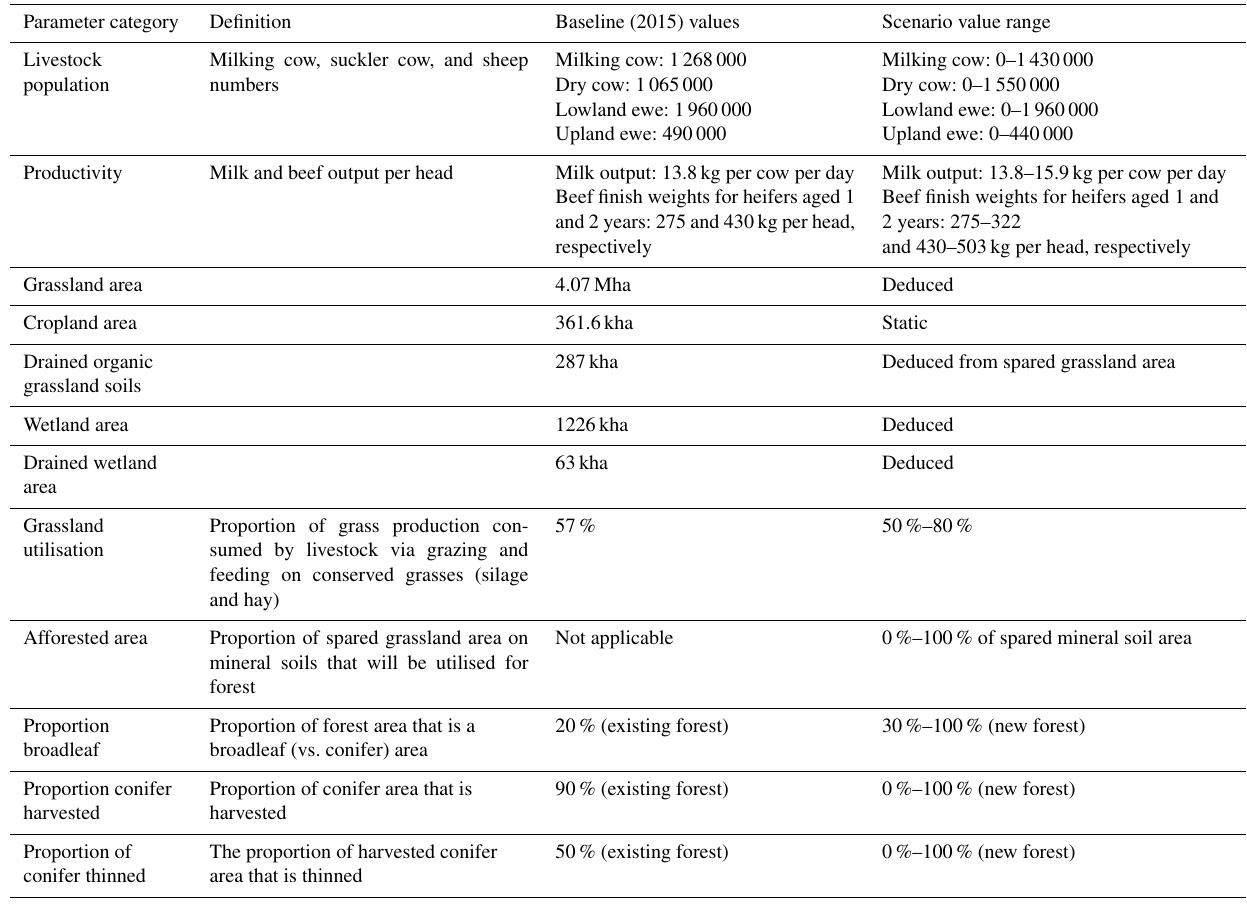
Table 2. Definitions and selected value range examples for key GOBLIN input parameters for the Irish system.